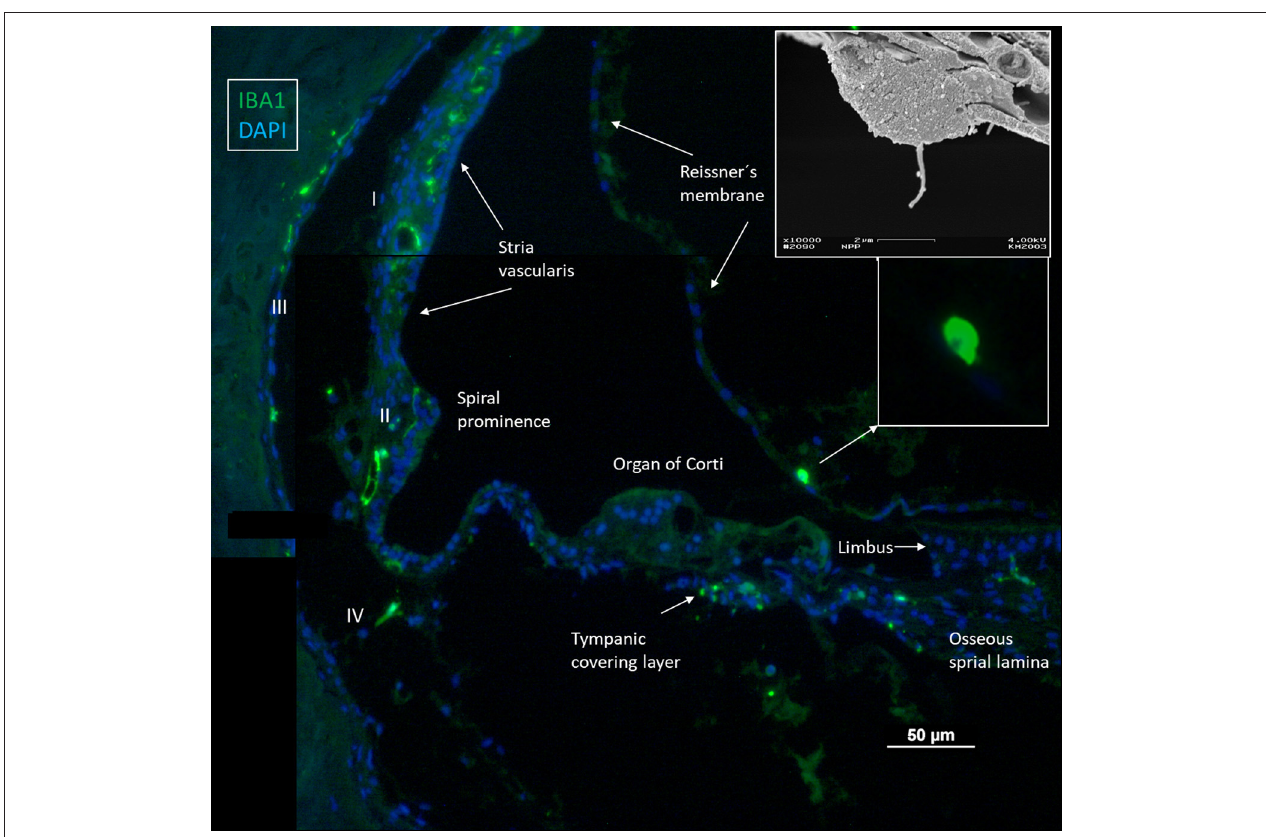
FIGURE 1 | Immunofluorescence of a radial section of a human cochlear duct showing the distribution of IBA1 cells. In the spiral prominence, some IBA1 cells almost reach the endolymph. Scanning electron microscopy shows a free cell transitioning a cell border in the human cochlea (upper inset). Reissner’s membrane (RM) may also contain macrophages (lower inset). In the SV, IBA1 cells are mostly found in the middle layer close to the blood vessels. No IBA1 cells can be observed in the organ of Corti in this section. I–IV;